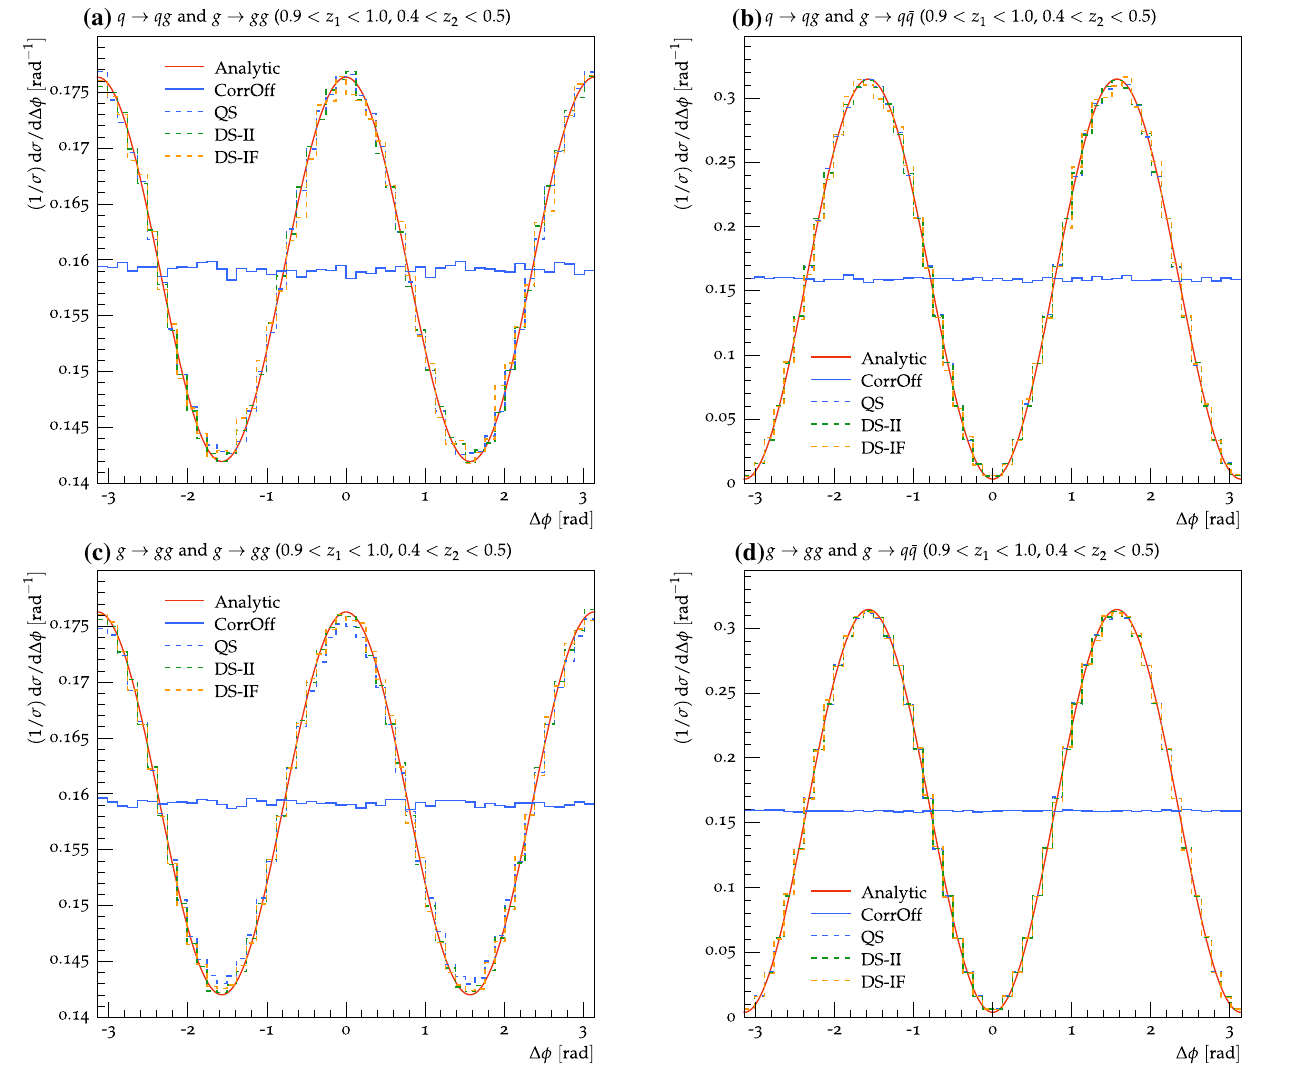
dictions obtained using only initial-initial (DS-II) and initial-final (DS- IF) dipoles in the dipole shower are shown separately. The prediction of the angular-ordered (CorrOff) shower without spin correlations is included for comparison. The momentum fractions in the first ( z 1 ) and second branchings ( z 2 ) lie in the ranges